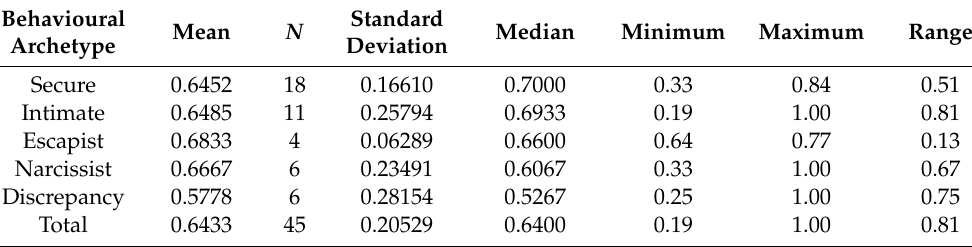
Table 19. Mean internal characteristic validity measure by behavioural archetype.